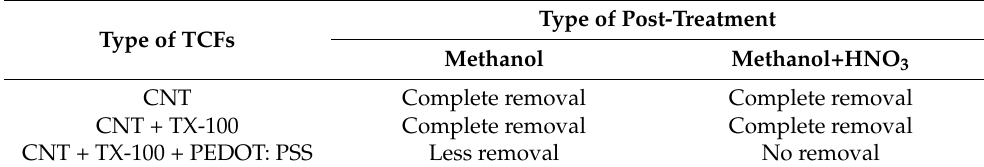
Table 3. Adhesion testing of different TCFs.